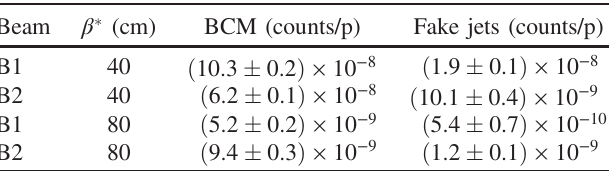
TABLE II. Ratio of background counts to the number of lost protons on the IR7 TCPs. Data, taken from Ref. [24], are shown for the ATLAS BCM and fake-jet counts in the ATLAS calorimeters, per lost proton on the IR7 TCPs. The shown results are for a TCT setting of 8 . 8 σ at β (cid:1) ¼ 40 cm and 13 . 7 σ at β (cid:1) ¼ 80 cm. The results are the average over the excitations in the horizontal and vertical planes. The indicated error margins correspond to the uncertainty coming from the background counting